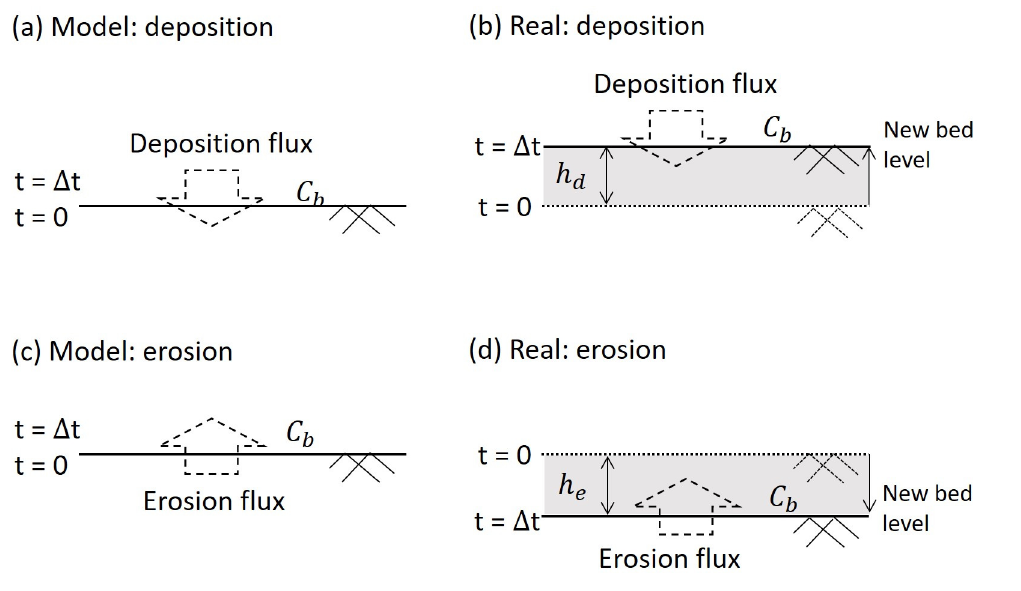
Figure 1. Schematic plot to show modeled deposition ( a ); real deposition ( b ); modeled erosion ( c ); and real erosion ( d